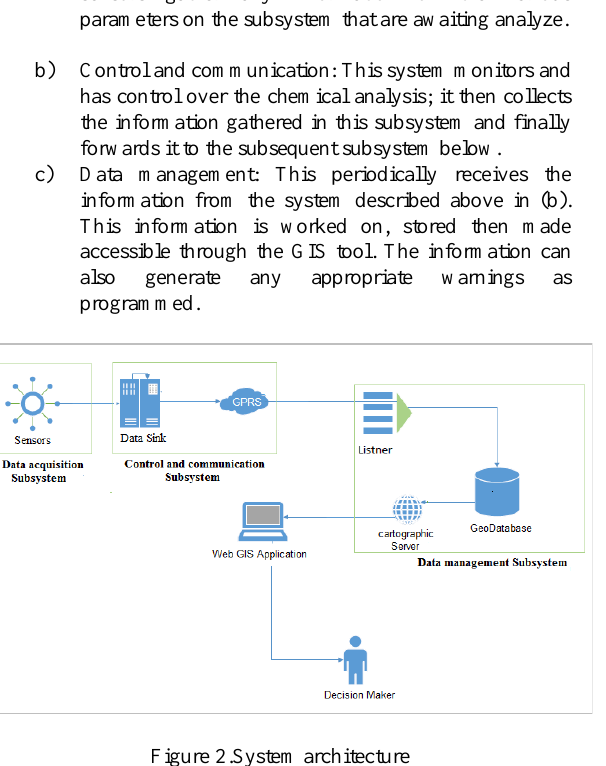
Figure 2.System architecture